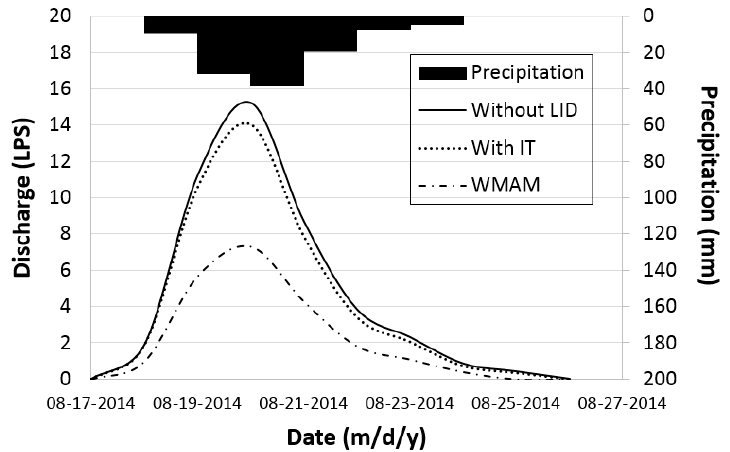
Figure 5. Hydrographs of subcatchment S5 for the three case studies.